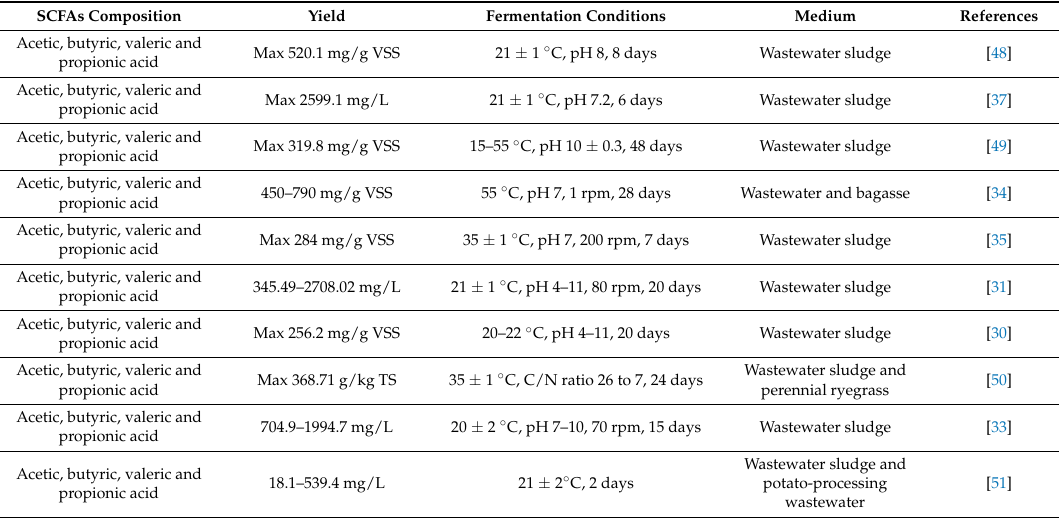
Table 2. Reported laboratory-scale studies for SCFAs production from WAS-derived